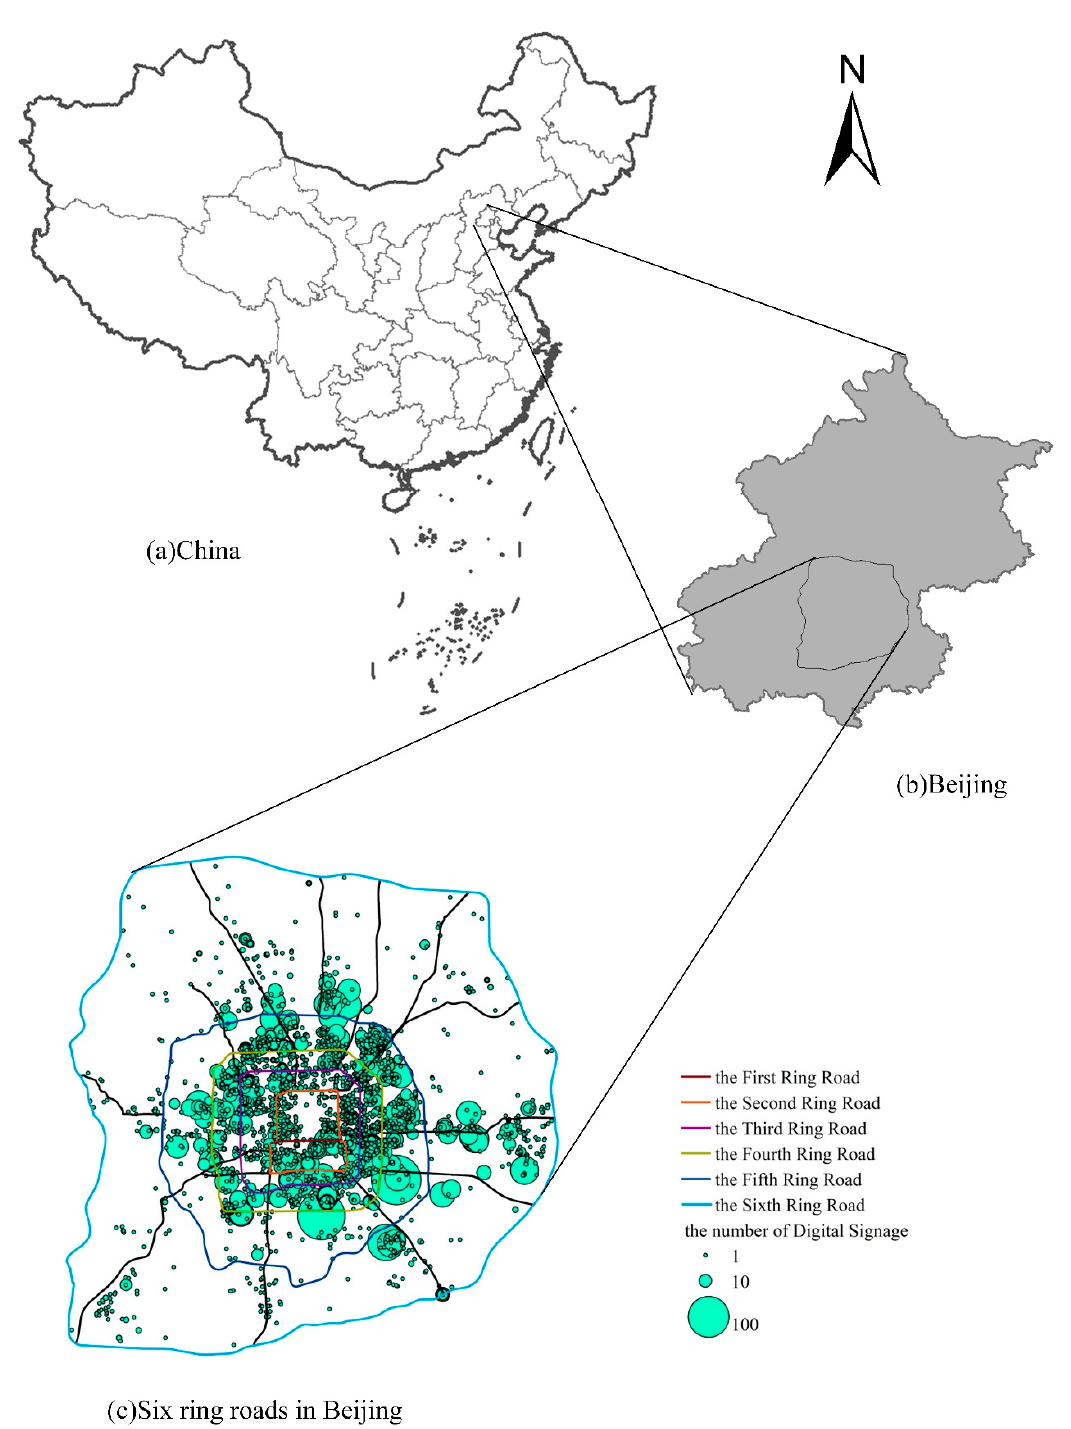
Figure 1. The area within the Sixth Ring Road in Beijing.